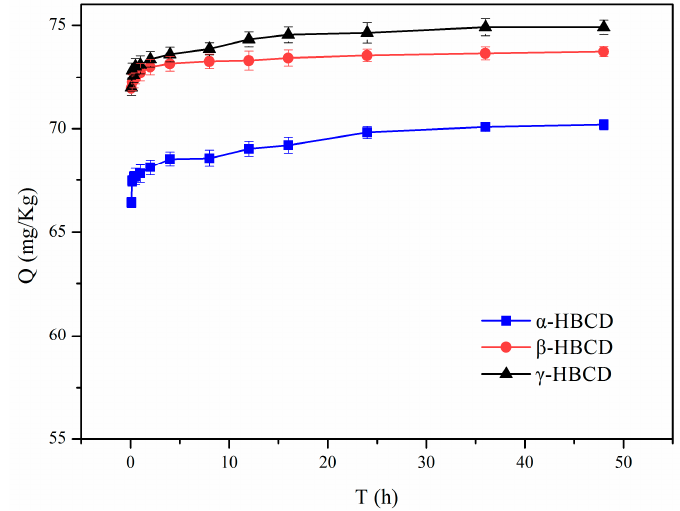
Figure 2. Sorption equilibrium time of hexabromocyclododecanes (HBCDs) in the sediment.